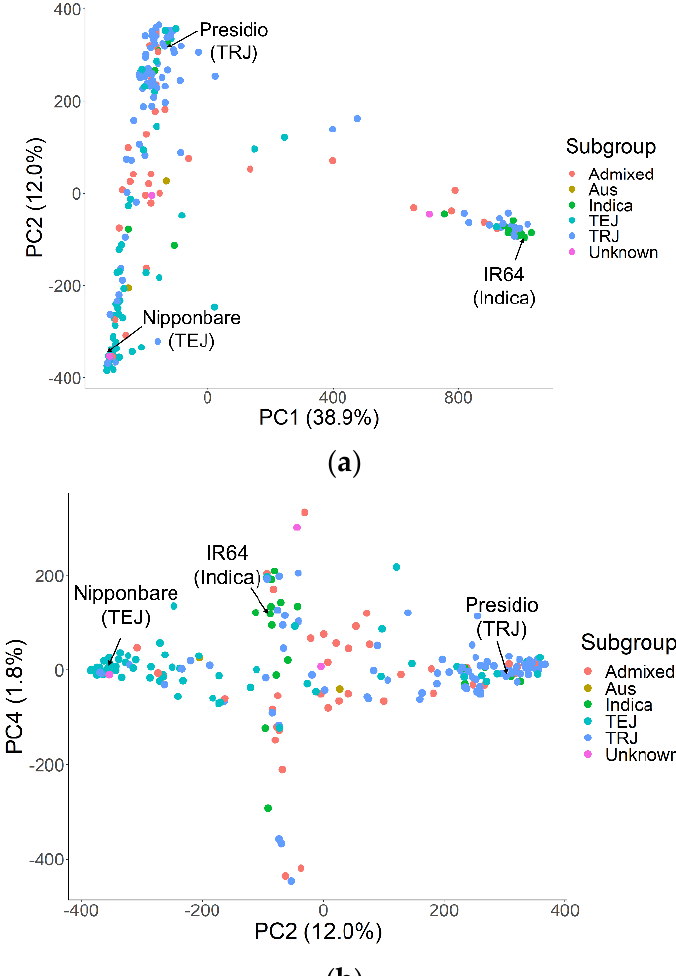
Figure 2. Principal component analysis (PCA) of rice accessions used in genome-wide association studies (GWAS) for protein and amylose concentrations, showing ( a ) PC1 by PC2 and ( b ) PC2 by PC4. IR64, Nipponbare, and Presidio are labeled as representatives of the indica , temperate japonica (TEJ), and tropical japonica (TRJ) subgroups, respectively.